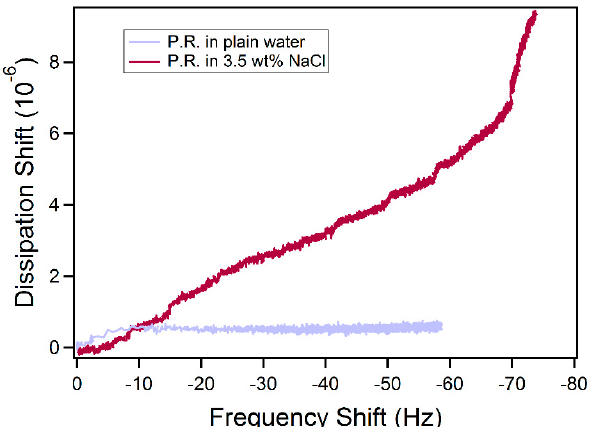
Figure 8. Variation of dissipation shift Δ D vs. frequency shift Δ f (5th overtone) during the adsorp- tion of P.R. rhamnolipid on a gold sensor surface from aqueous solution and from 3.5 wt.% NaCl aqueous solution.